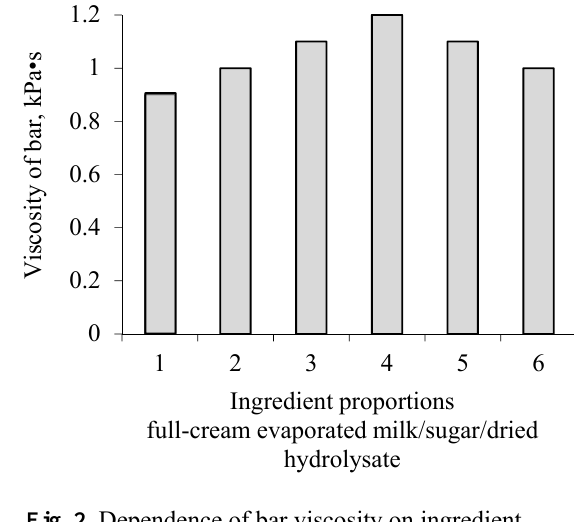
Fig. 2. Dependence of bar viscosity on